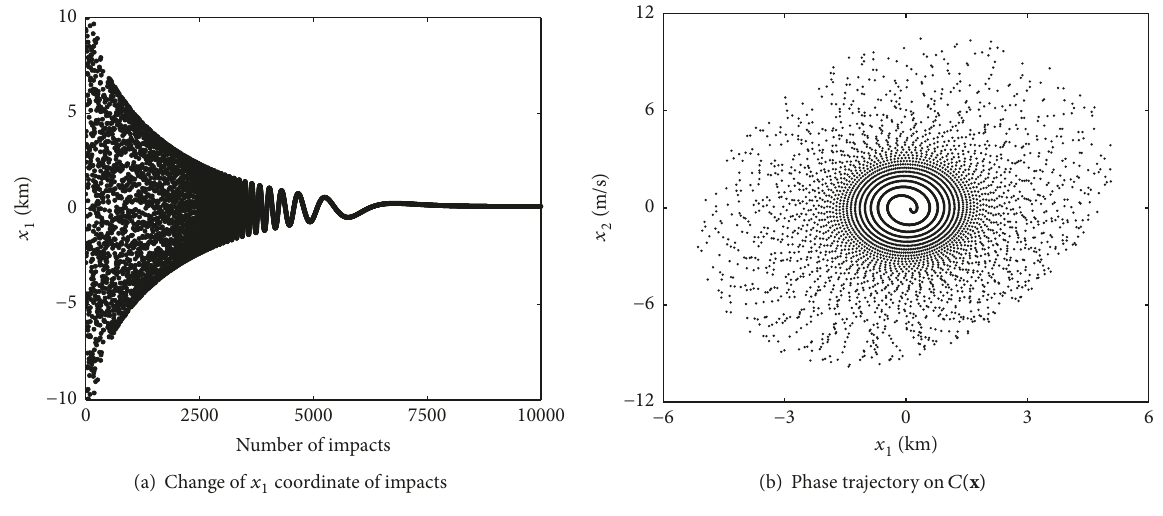
Figure 11: Irregular motions with damping factor.